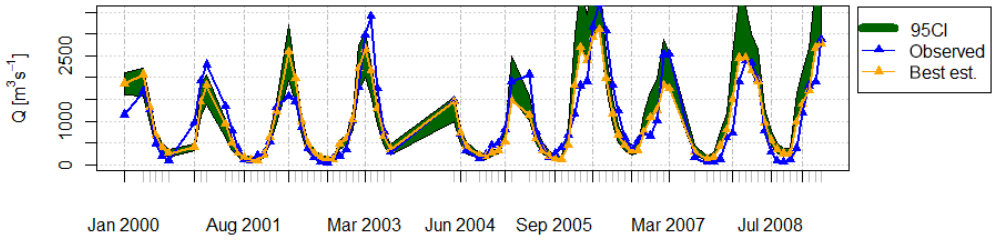
Figure 4. Calibration and validation with land-use update for the Jamanxim catchment.